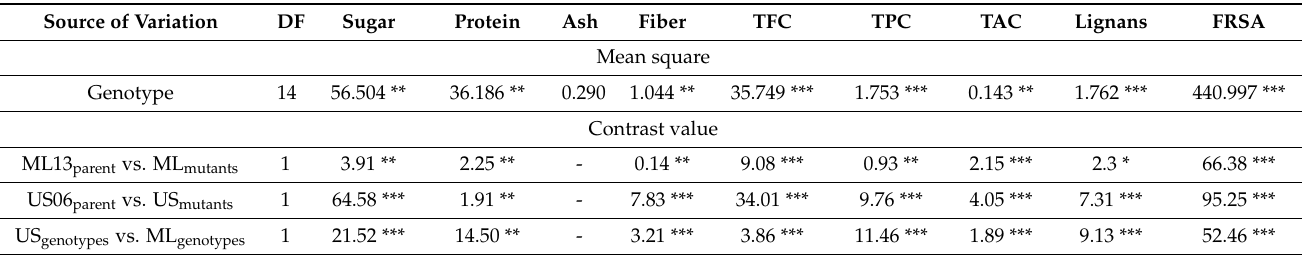
Table 1. Results of analysis of variance for 15 sesame genotypes (13 mutant lines and their 2 parents) evaluated for various quality traits (mean square, value of contrast and level of difference